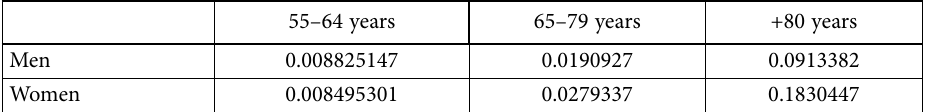
Table 1. Prevalence rates in the Spanish population (source: own elaboration from Instituto de Mayores y Servicios Sociales, 2019)